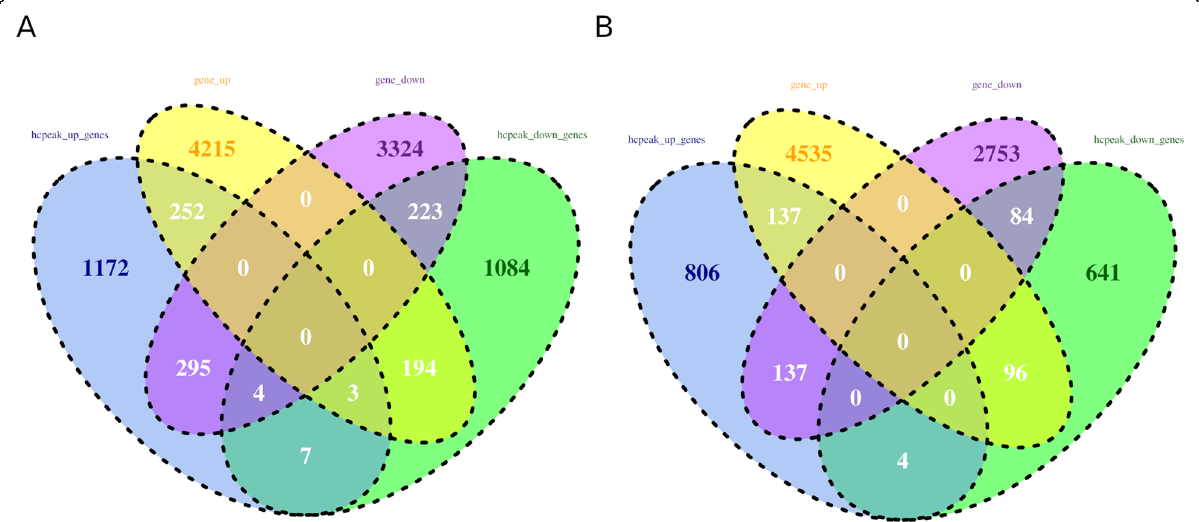
Fig. 7 Compare the differential hcpeaks and DE genes. ( A ) comparison of genes overlapping with differential hcpeaks and DE genes in cv. 9311_cd vs. cv. 9311_ck ( B ) comparison of genes overlapping with differential hcpeaks and DE genes in cv. NIP _ cd vs. cv. NIP